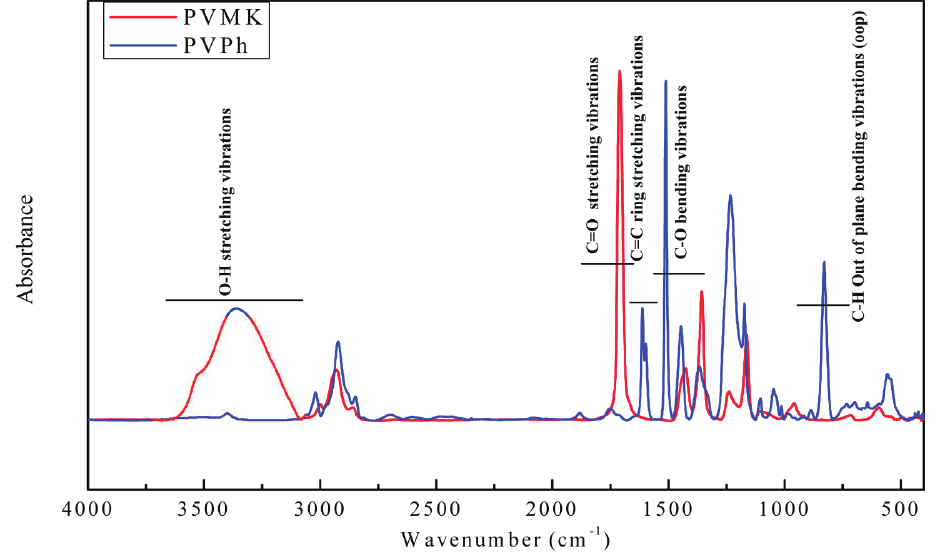
Figure 3. Infrared spectra of PVPh and PVMK in the 400–4000 cm − 1 region.